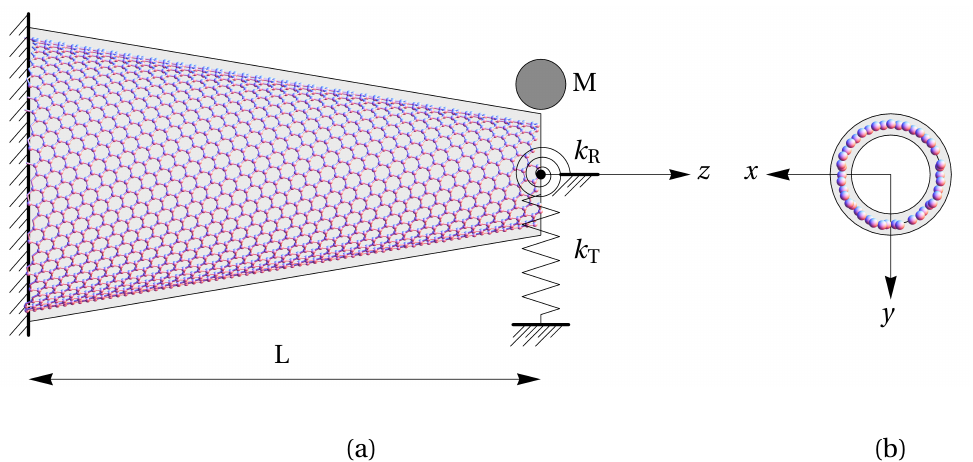
Figure 1. Geometry of a nanocone having an apex angle of 19.18 ◦ ; length of 80 Å; and radii of 21.8 Å and 8 Å at the anchored side and at the tip, respectively, superimposed on the corresponding tapered beam model ( a ) and front view of the tip of the nanocone superimposed on the hollow circular cross-section of the beam model ( b ). The wall thickness of the cross-section at the continuum level is accepted as 3.4